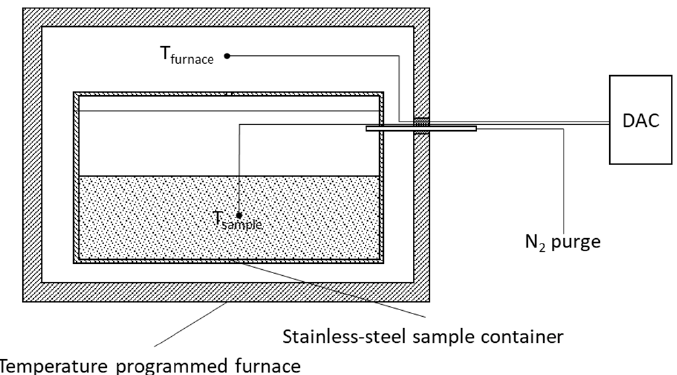
Figure 1. A schematic of the main components of the system used in the production of biochar in furnace experiments.